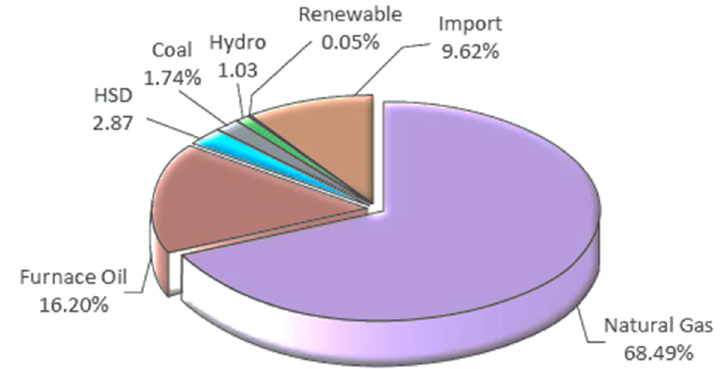
Figure 1. Grid energy generation mix of Bangladesh in financial year 2018–2019. Total generation was 70.53 GWh, which includes imports from India [23].